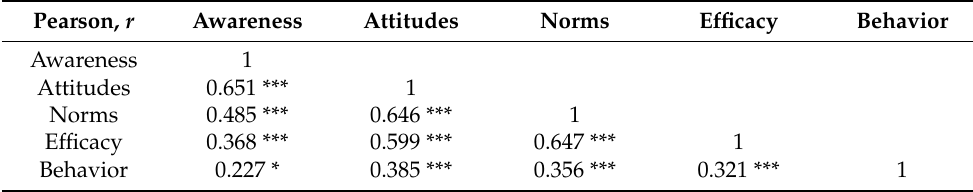
Table 9. Correlations among constructs for Experimental Group (post-test). Pearson, r Awareness Attitudes Norms Efficacy Behavior Awareness 1 Attitudes 0.816 *** 1 Norms 0.614 *** Efficacy 0.537 ***